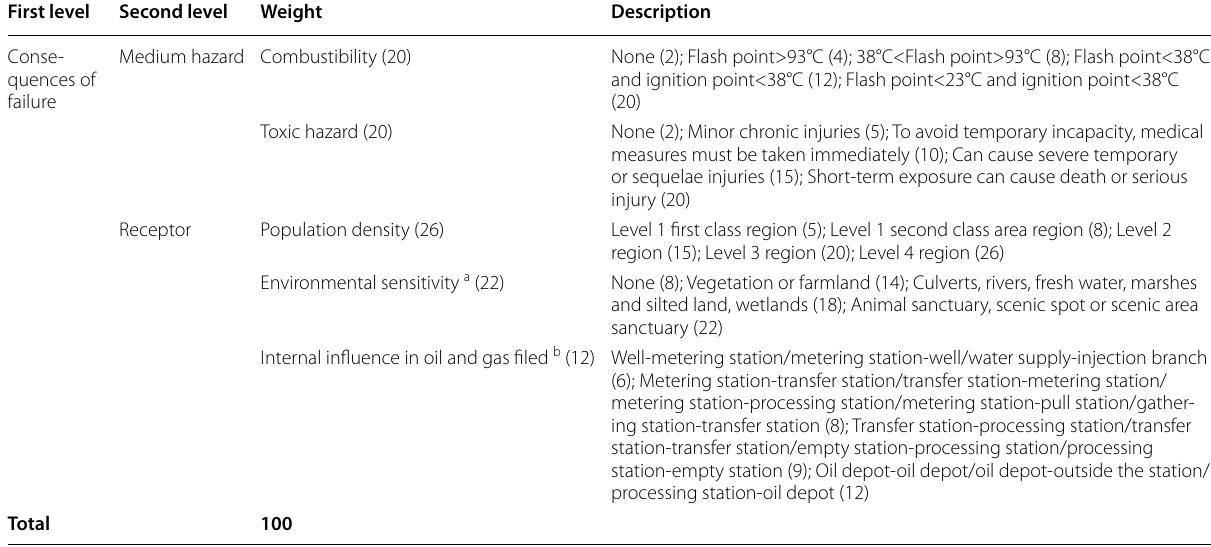
Table 6 Consequences of failure